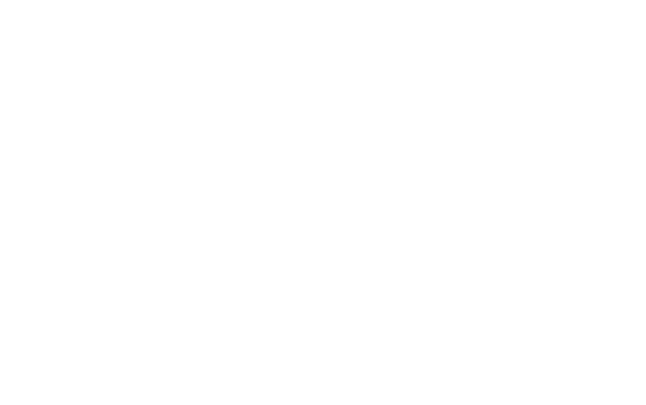
Figure 2. Histograms showing circulating levels of miR-122 according to the etiology of the underlying liver disease (representing median with error bar showing the third quartile). Patients with viral HCC had statistically significantly higher levels of circulating miR-122 compared to patients with alternative etiologies ( p = 0.006). The median of miR-122 circulating levels in patients with viral etiology is 2.91 fc [1.62–9.82], a value statistically significant higher compared to the level registered in patients with alternative etiologies (1.76 fc [0.86–2.86]; p = 0.006). ** p ≤ 0.01.